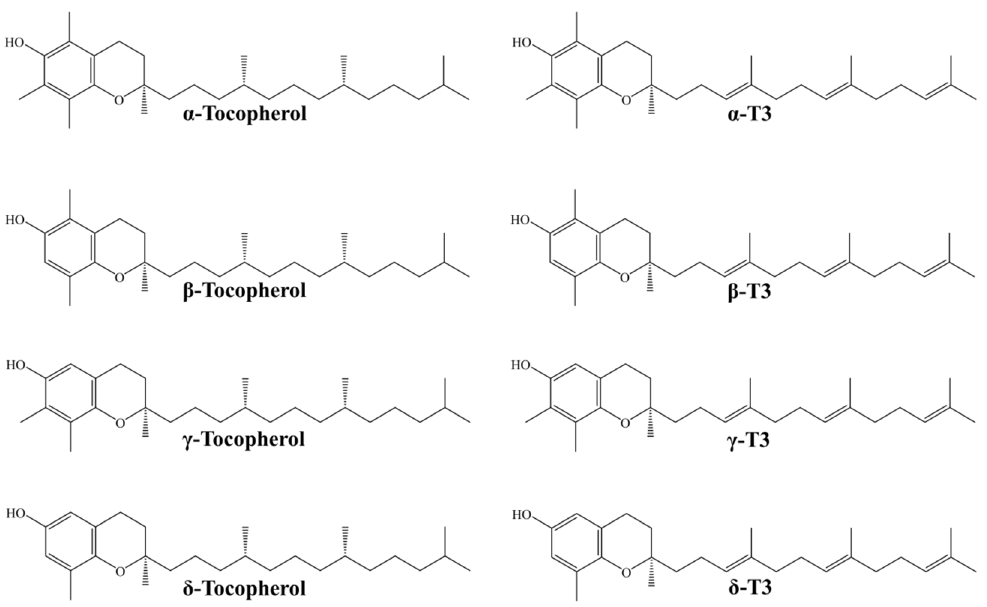
Figure 1. The chemical structure of four tocopherol and tocotrienol isoforms.